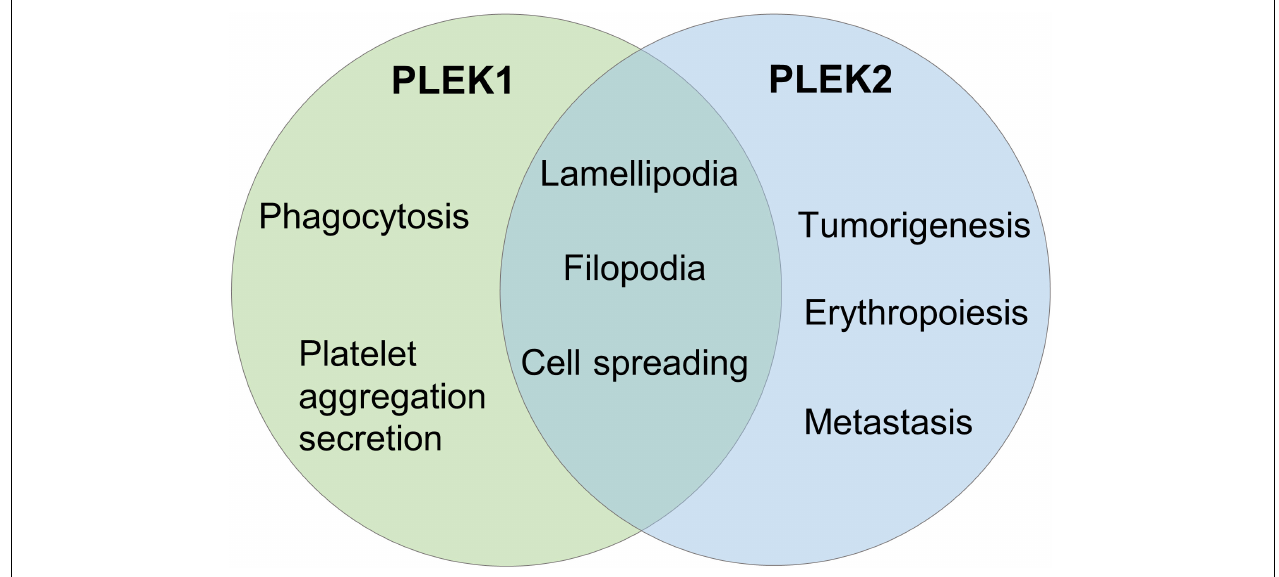
FIGURE 2 | The biological function of PLEK2 and PLEK1. TABLE 2 | The biological functions and interacting molecules of PLEKs.